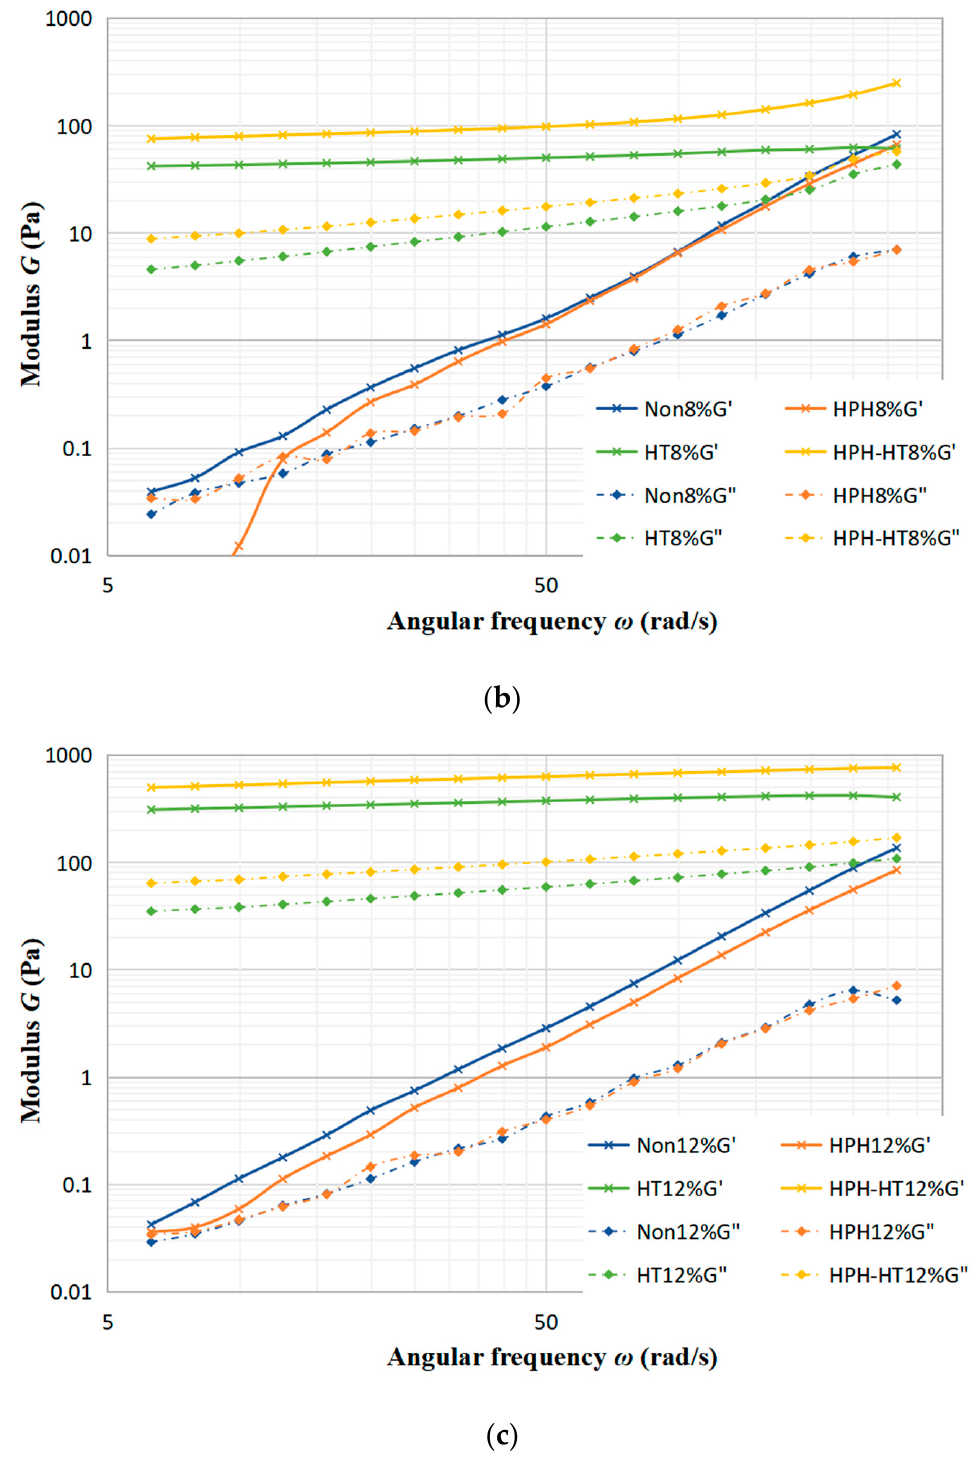
Figure 5. Trends of storage modulus G ′ and loss modulus G ″ with frequency under di ff erent treatments at various concentrations of DCF dispersion.